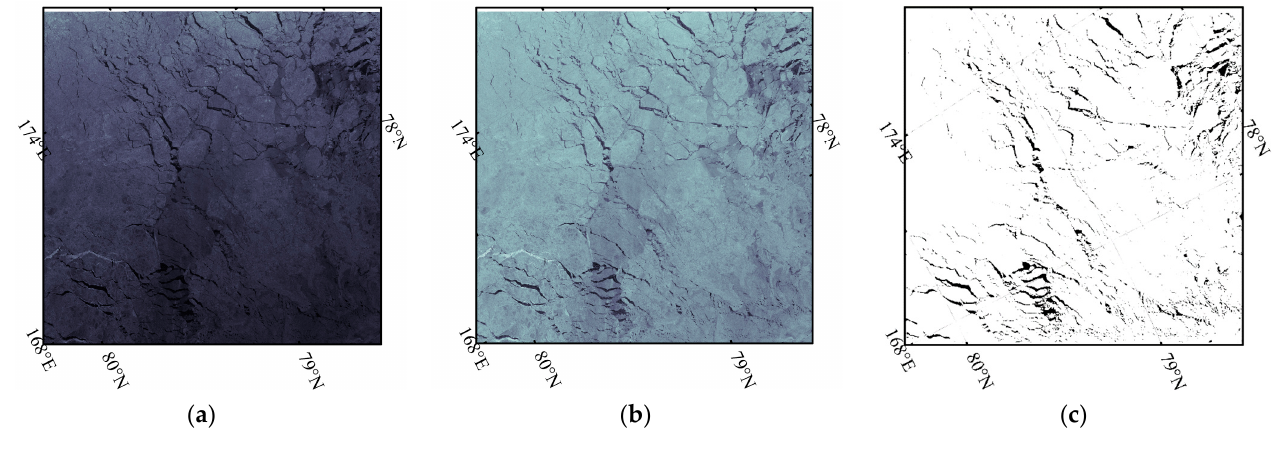
Figure 5. Example of Sentinel-1 SAR image processing results: ( a ) the original SAR image; ( b ) the SAR image after radiation correction, incidence angle correction, and filtering; and ( c ) the image after K-means segmentation.